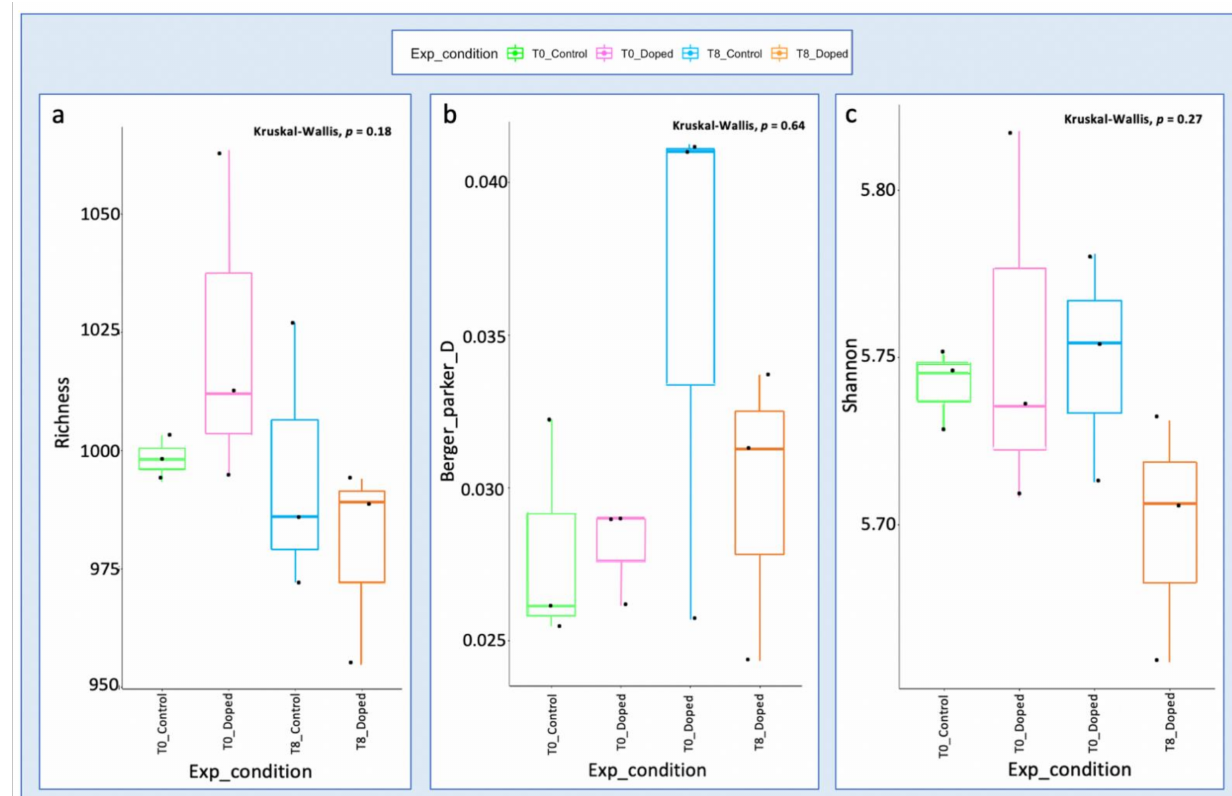
Figure 4. Alfa diversity index of the microbial community in the different CWs systems, irrigated for eight weeks with Ribeira de Joane water not doped (control) or doped with NP and OP. Samples collected at the beginning (T0) and at the end of the experiment (T8) ( n = 3). ( a ) Richness (number of observed OTUs); ( b ) dominance (Berger–Parker index); ( c ) diversity (Shannon diversity